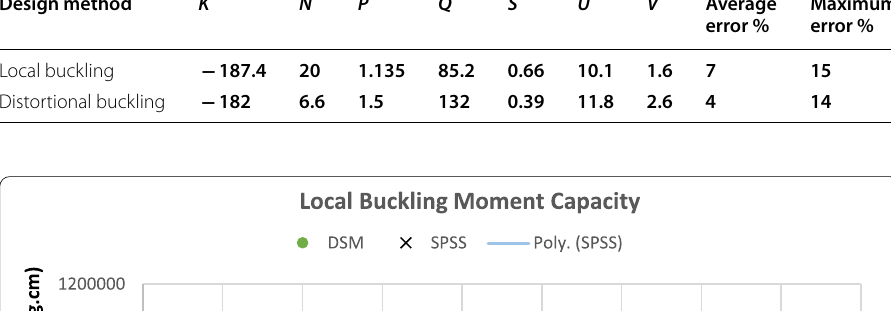
Table 1 The values of the constants used in the prediction equations for the local and the distortional buckling mode using DSM obtained using imperial units Design method